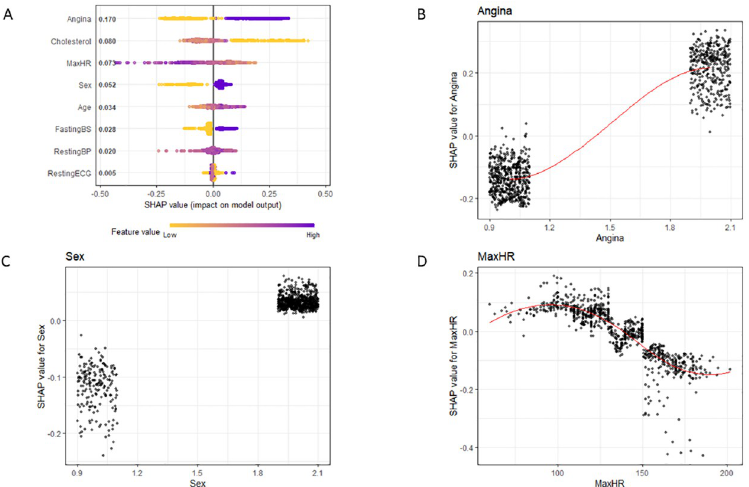
Fig 2. SHAP analysis. For the XGBoost models A) Overall Model detailing feature importance, with purple values representing High values and yellow values representing low values of each covariate. B) Model effect for Angina (1 – presence of angina) C) Model effect of Sex (1 –Female, 2 –Male) D) model effect for max heart rate